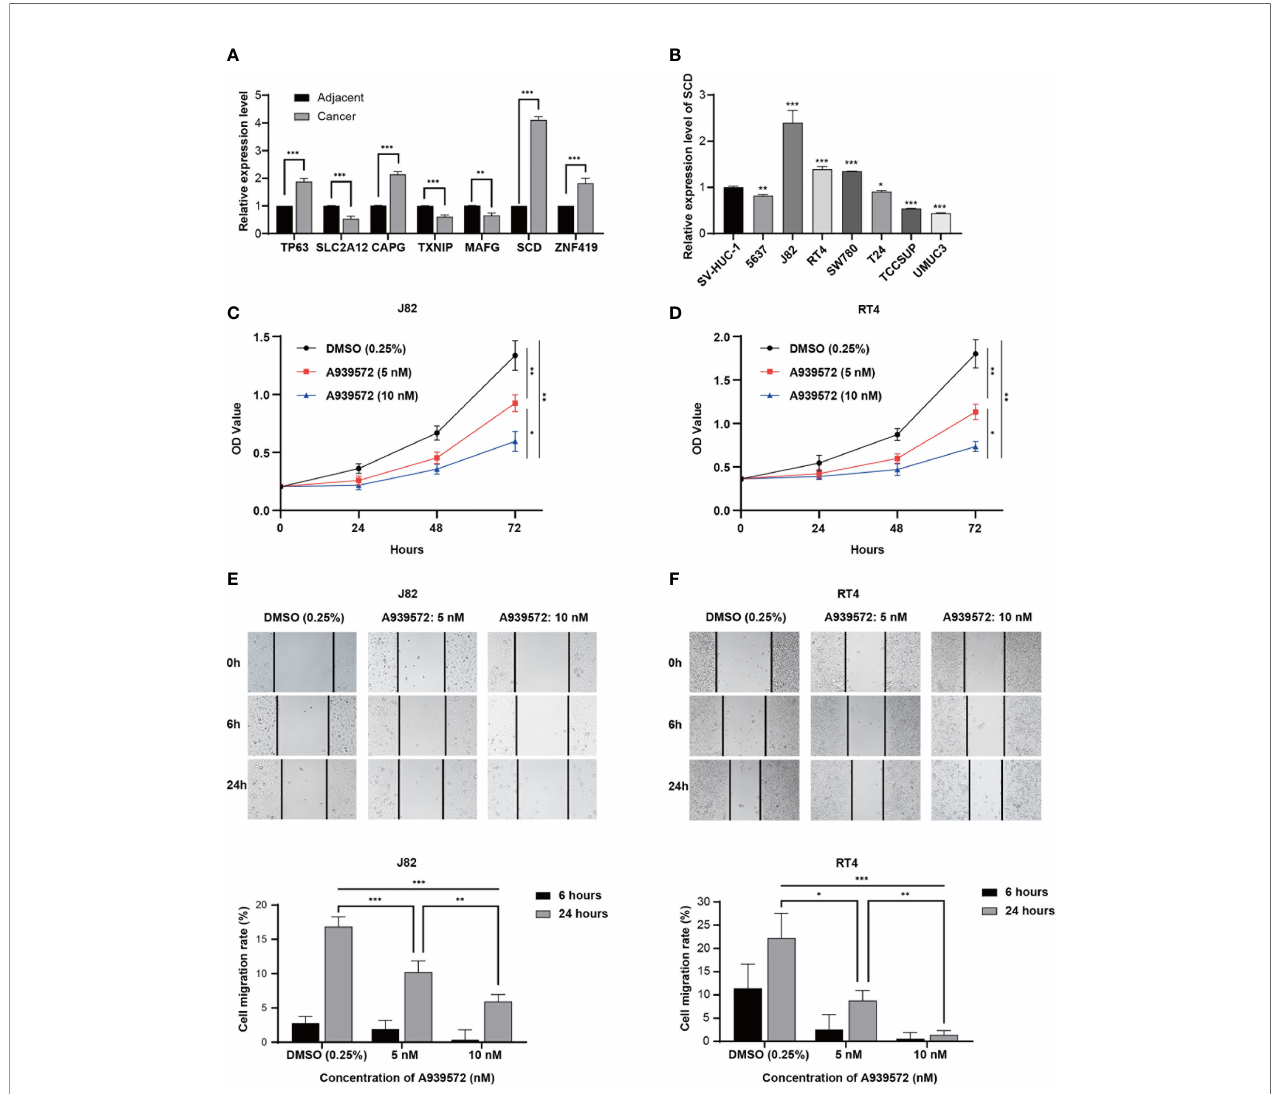
FIGURE 7 | Experimental veri fi cation processes. (A) Marplot exhibiting the relative expressions of the seven genes evaluated by RT-qPCR in 16 bladder cancer samples and paired normal samples. (B) Relative expression levels of SCD in eight cell lines. (C, D) CCK-8 assay results show the relative proliferation of the J82 and RT4 cells after the addition of A939572. (E, F) Scratch assay results showed migration rates of the J82 and RT4 cells. In the fi gure, the data were shown as means ± S.D. *P < 0.05, **P < 0.01, ***P <